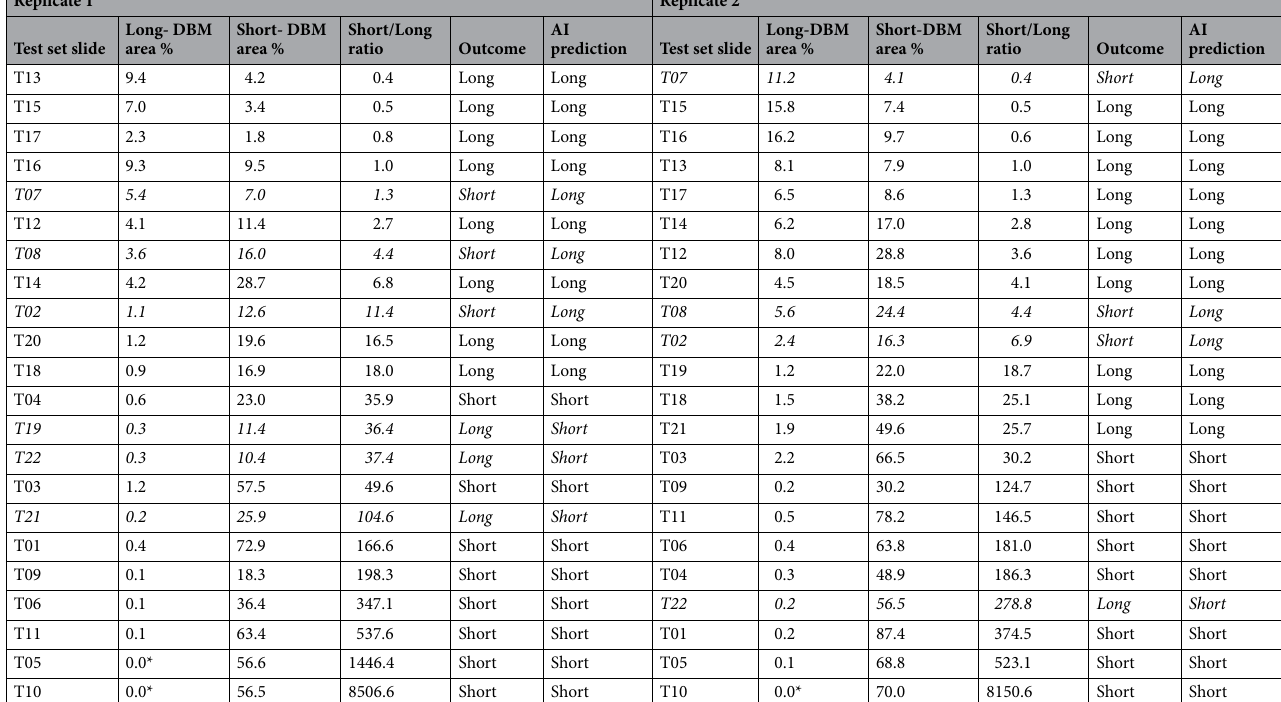
Table 3. Results and classification of validation test set replicates. Digital biomarker (DBM) area refers to percent of total tumor area classified as a biomarker. Outcome refers to the actual PFI group. Italicized rows are slides incorrectly classified by the neural network. *Does not represent true 0%.